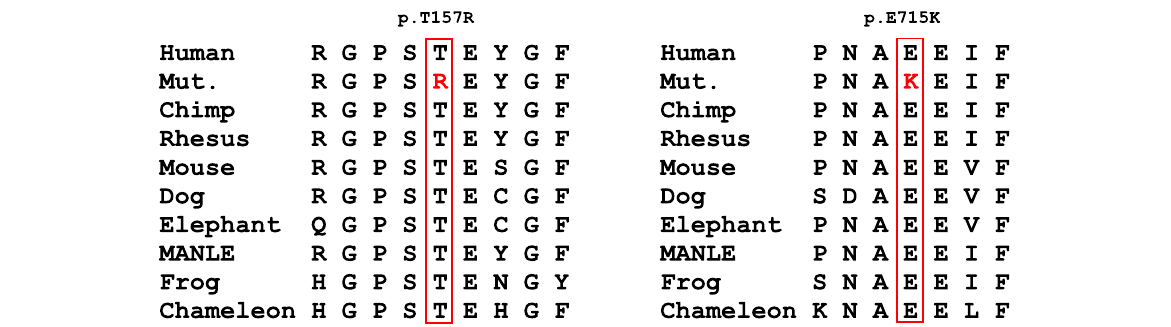
Fig. 4 The variants region is conserved among human, Chimp, Rhesus, Mouse, Dog, Elephant, MANLE, Frog, and Chameleon. Mut., mutant; MANLE, Mandrillus leucophaeus